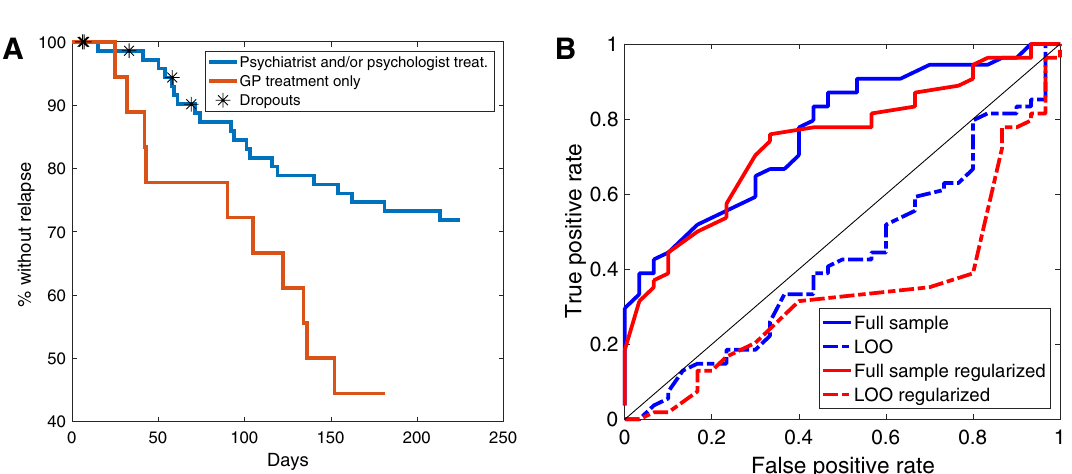
Figure 2. ( A ) Survival curves for time until relapse during follow-up period for patients who were only treated by a general practitioner (GP) or additionally by a psychiatrist or psychologist. ( B ) Prediction: Receiver operating curves for a standard general linear model (blue) and a regularised general linear model using least absolute shrinkage and selection operator and elastic net (red) using the full sample (solid lines) and for subjects left out of the fit using leave-one-out (LOO) cross-validation (dashed